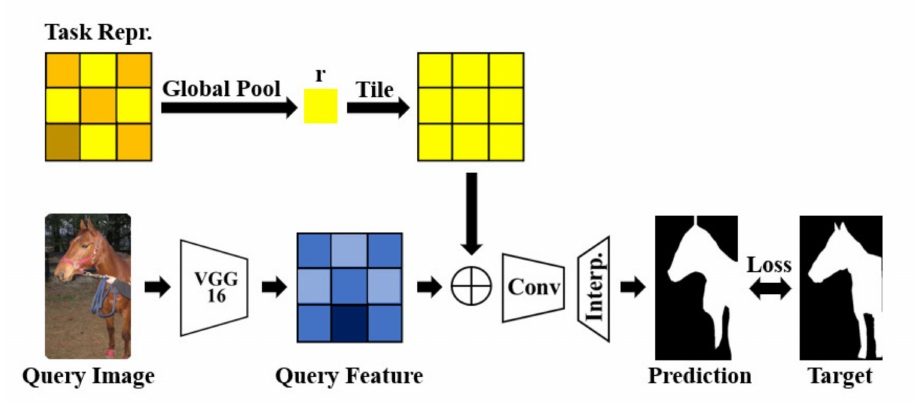
Figure5. Illustrationofthesegmentationbranch. Thispartdescribesthefusionofthetaskrepresentation with the query features and generates rough prediction